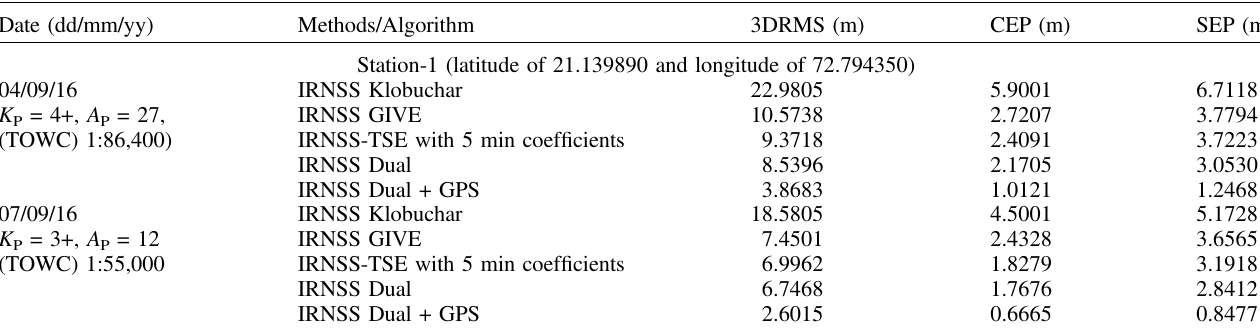
Table 1. The statistical positional error analysis at rover station